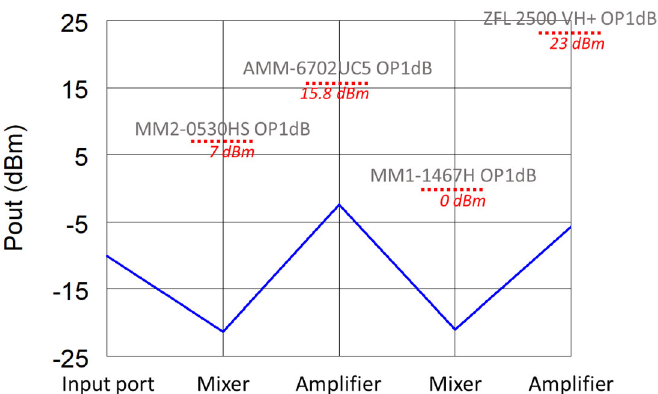
Figure 7. Power budget of the receiver. The input power is equal to − 20